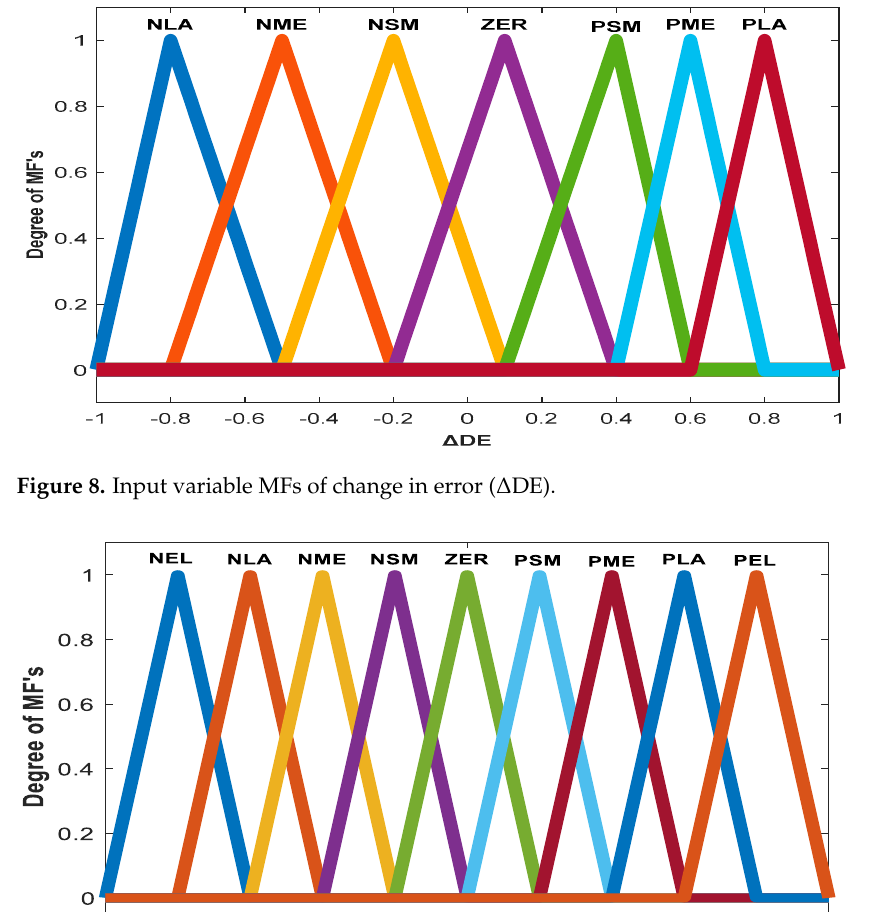
Figure 7. Input variable MFs of error ( Δ E).